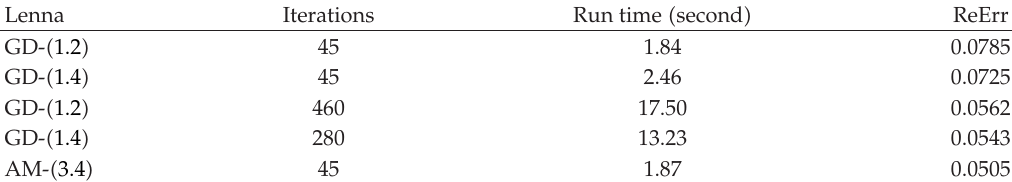
Figure 4: Relations between number of iterations (cid:3) abscissa axis (cid:4) and value of ReErr (cid:3) vertical axis (cid:4) by the three methods for “pepper”. Table 1: Number of iterations, computational time, and ReErr of the three methods for the results in Figures 1 and 2.